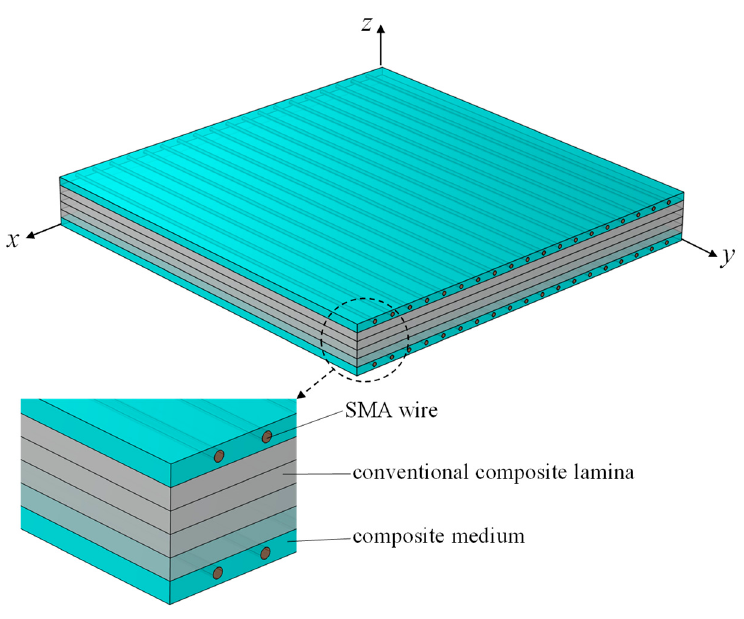
Figure 1. The sketch of the considered SMAHC plate and its coordinate system.